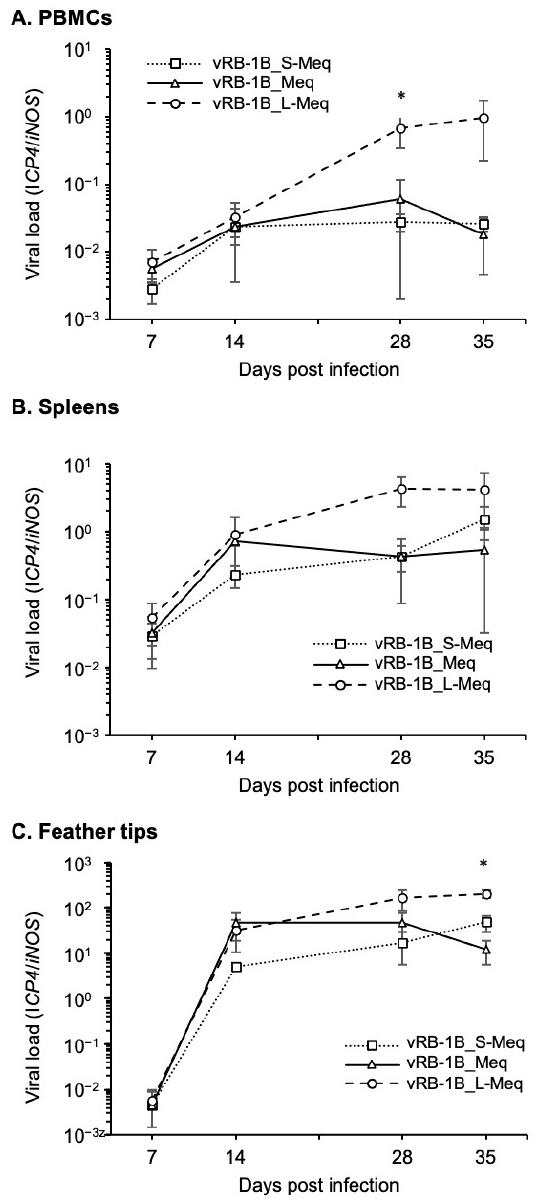
Figure 4. Replication of recombinant MDVs in vivo. The viral loads in the ( A ) peripheral blood mononuclear cells, ( B ) spleens, and ( C ) feather tips from chickens infected with vRB-1B_S-Meq, vRB-1B_Meq, and vRB-1B_L-Meq were determined by quantitative polymerase chain reaction. Asterisks indicate significant differences (* p < 0.01; Kruskal–Wallis test).